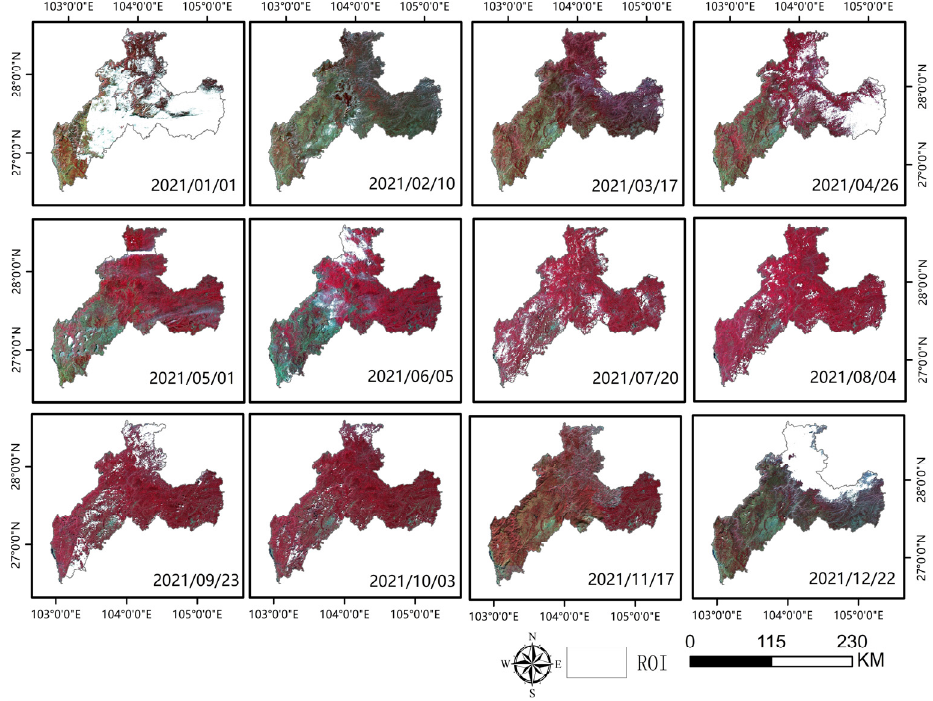
Figure 17. Time-consistent monthly images of Zhaotong City in 2021.